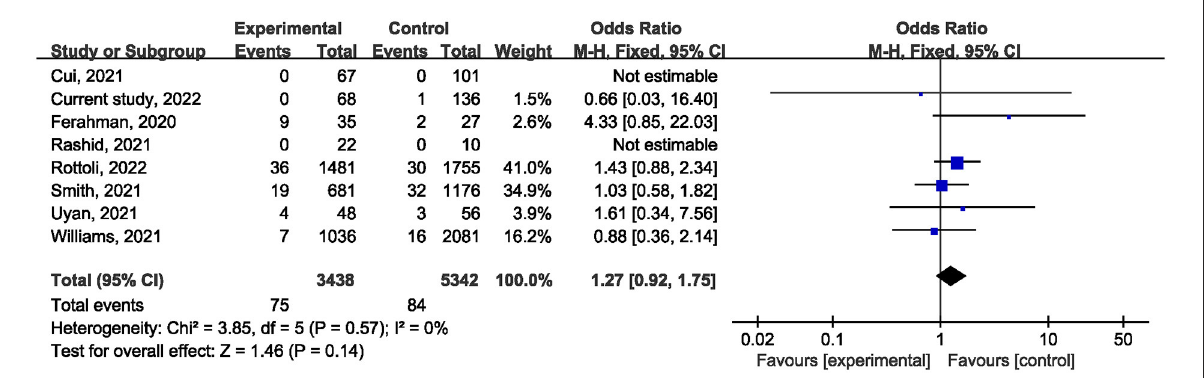
FIGURE4 The impact of the COVID-19 pandemic on postoperative mortality.